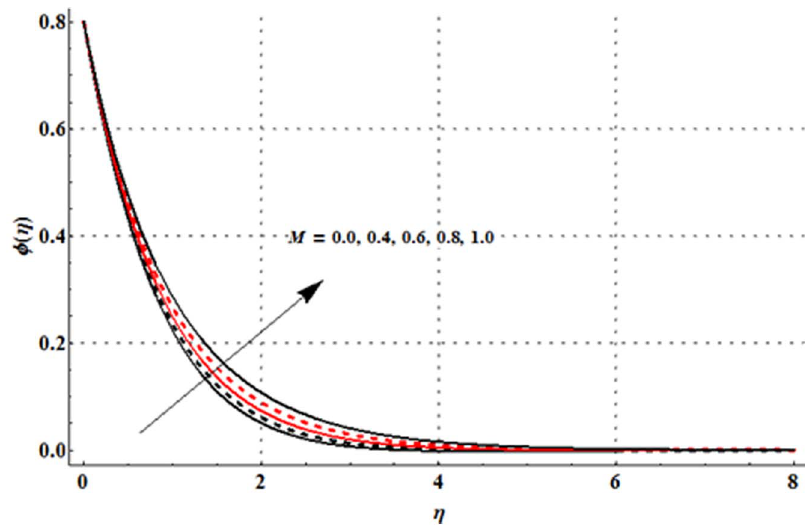
Figure 16. Influence of M on the concentration profile w ( g ) when b ~ 0 : 4 ~ Rd , l 1 ~ 0 : 5, l ~ 0 : 3 ~ N , Pr ~ 1 : 2, S ~ 0 : 2 ~ S (cid:2) and Sc ~ 1 : 0 :